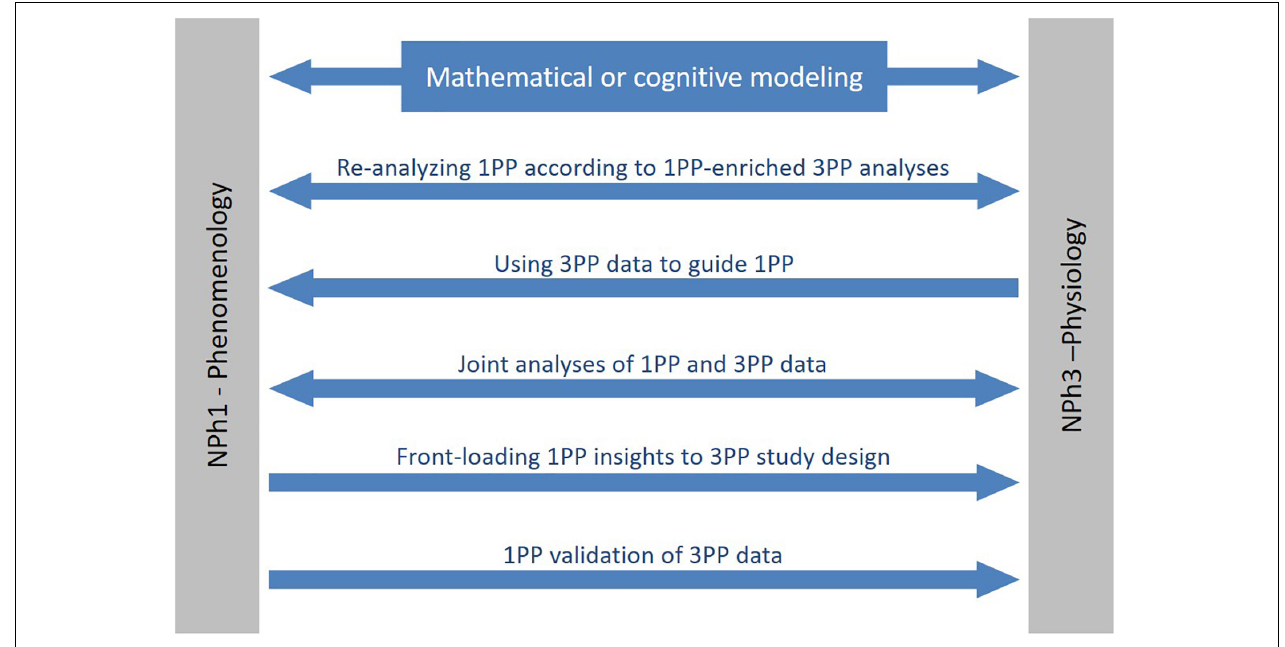
FIGURE 2 | A typology of ways of bridging the irreducible domains of experience and physiology. NPh, neurophenomenology; 1PP, 3PP, first/third person perspective,